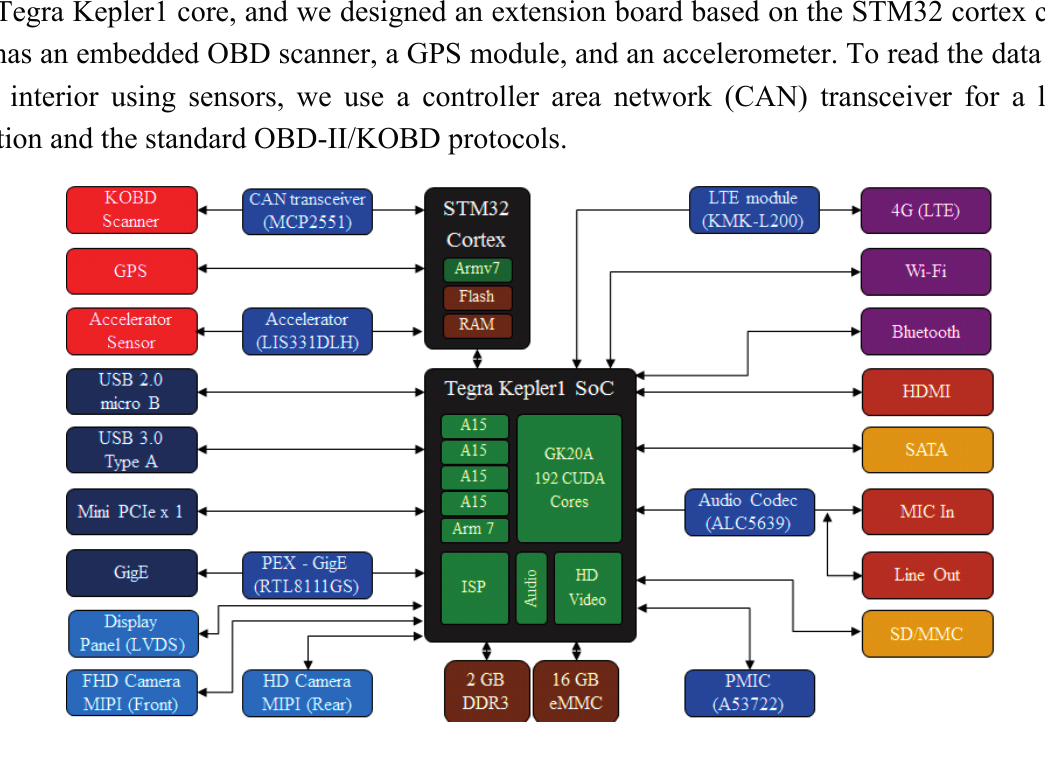
Figure 1. Schematic representation of smart camera platform based on NVIDIA Tegra Kepler1